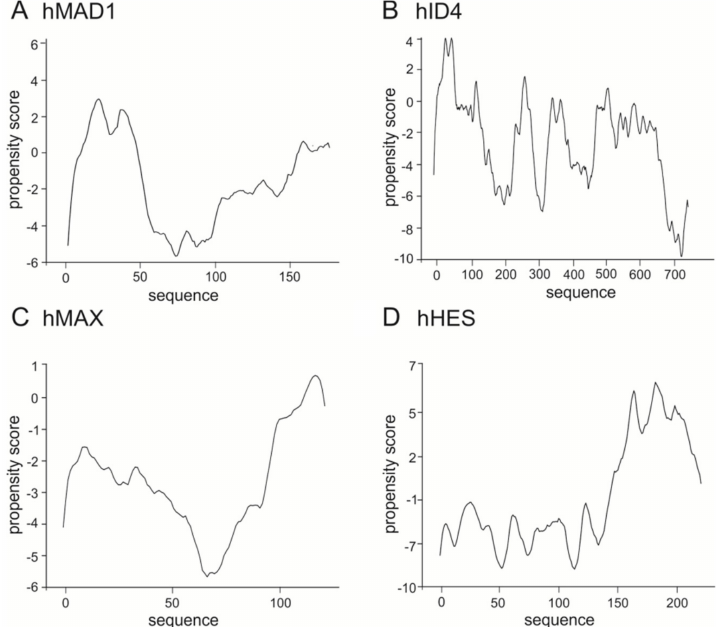
Figure 5. Prediction of propensity of LLPS formation. ( A ) class IV human MAD [Q05195] and ( B ) human MAX [P61244], ( C ) class V human ID4 [P47928], ( D ) class VI human HES1